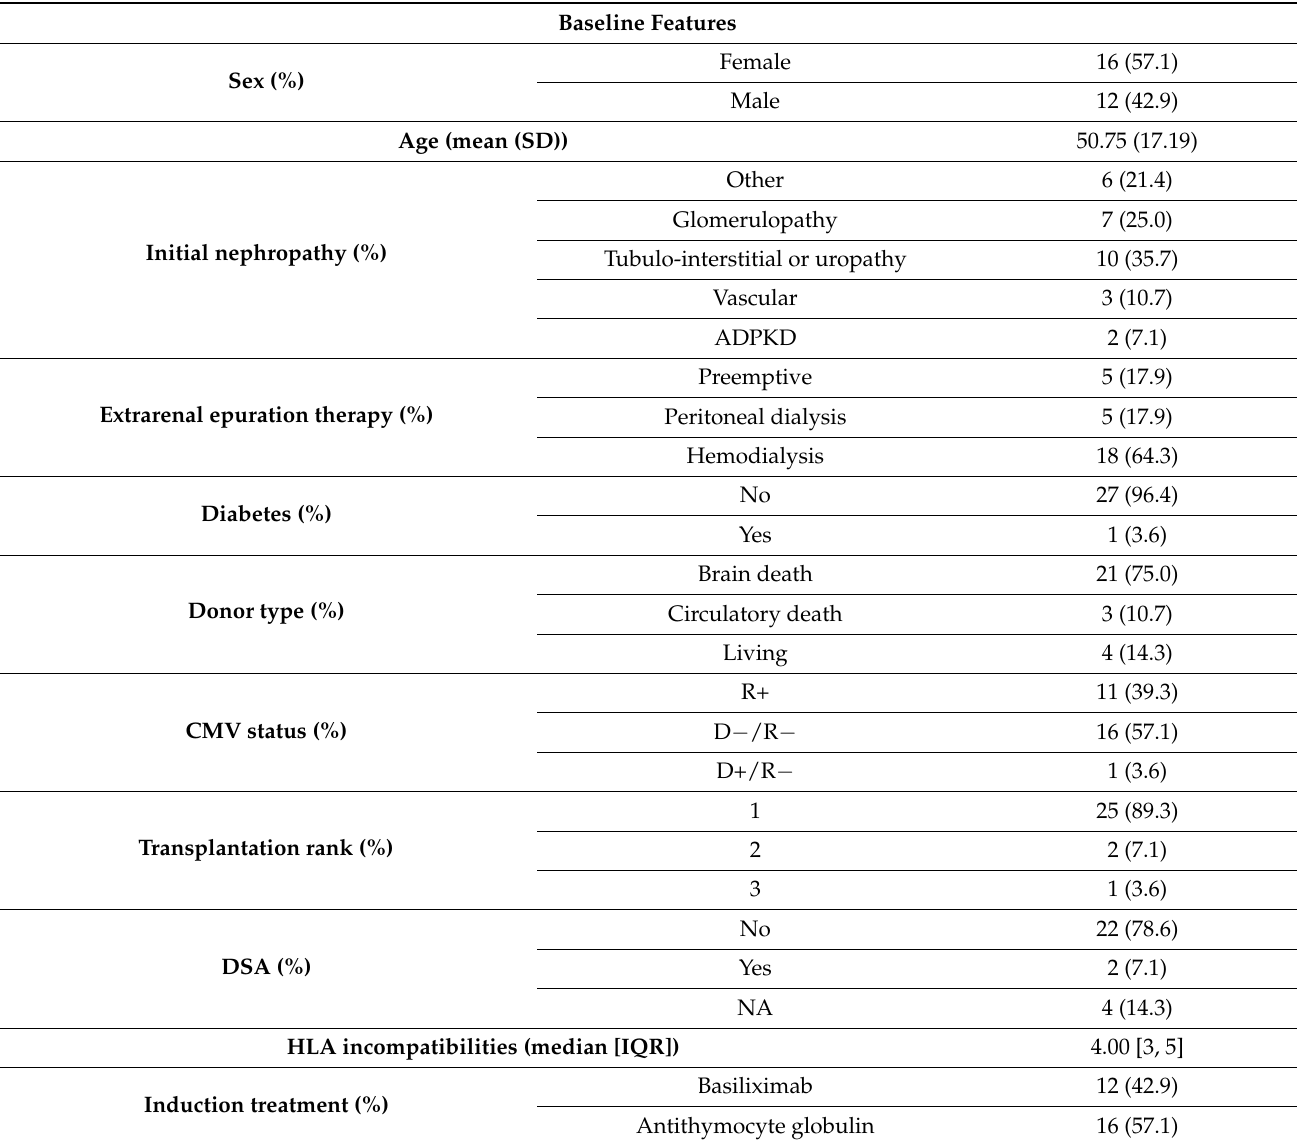
Table 1. Patient’s characteristics at baseline and belatacept conversion. ( n = 28 patients for whom belatacept has been withdrawn